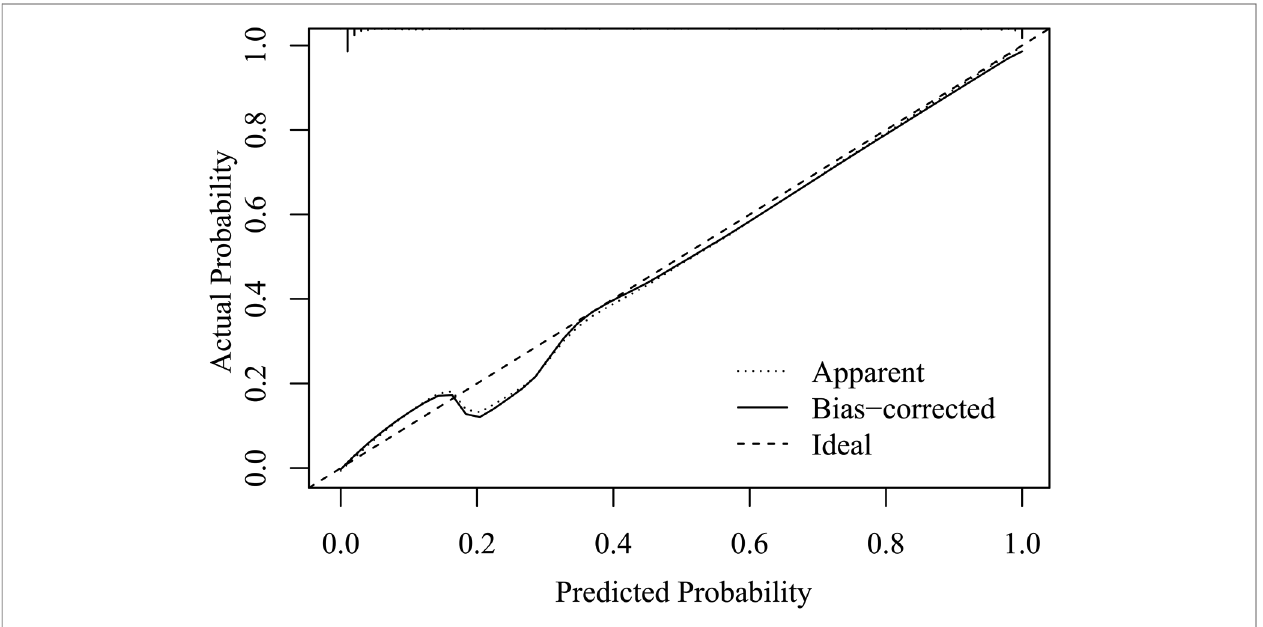
FIGURE 6 | Calibration Plot of the Internally Validated Model for the Bootstrap